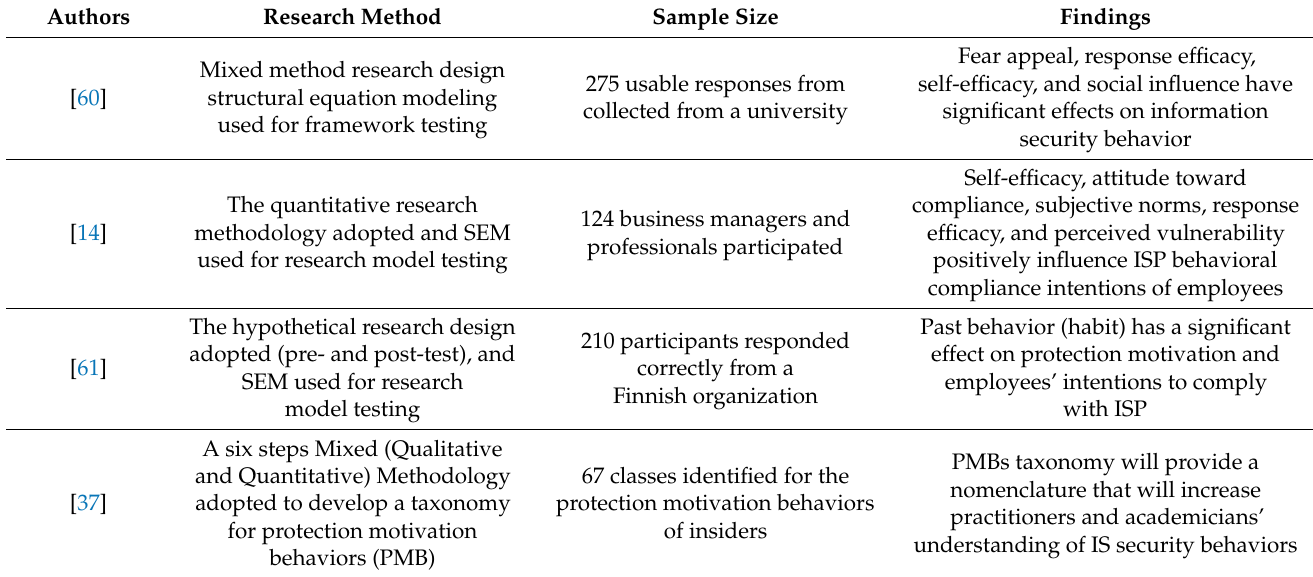
Table 6. Studies on PMB’s and